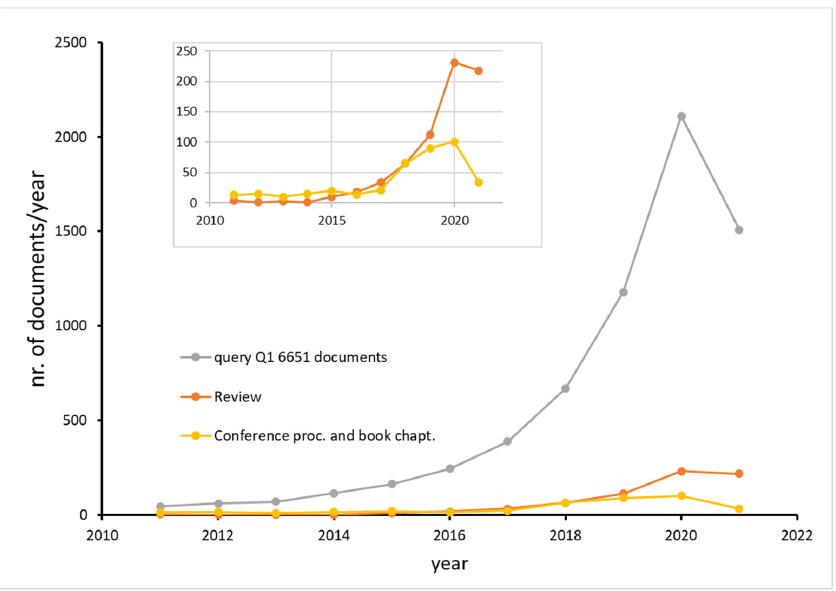
Figure 1. Trend of the number of total documents, reviews or conference proceedings and book chapters published from the year 2010. chapters published from the year